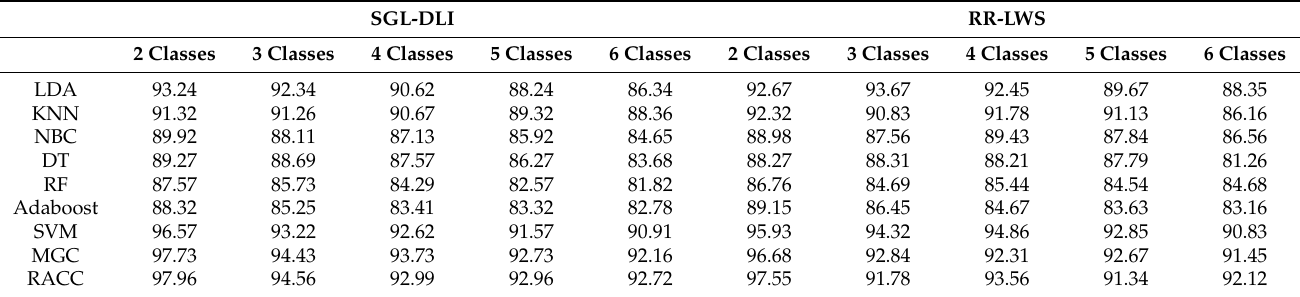
Table 2. Hierarchical clustering with SVD-based spectral algorithm. SGL-DLI